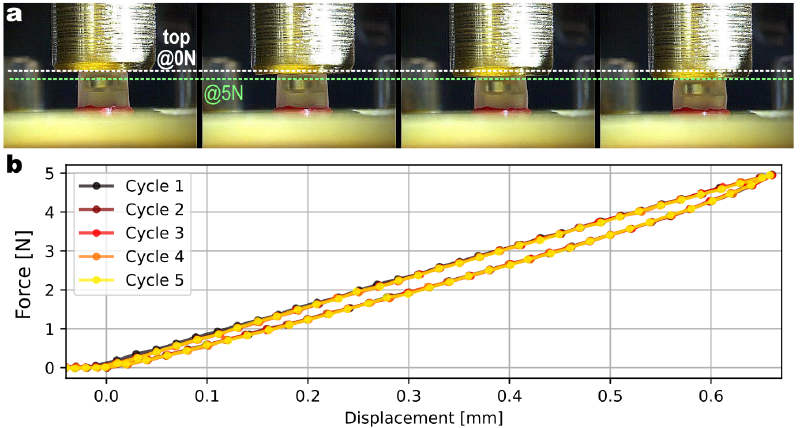
Figure 6. Mechanical response. ( a ) Time-lapse with increasing indentation and compression force, illustrating the mechanical deformation of the elastomer. ( b ) Applied compression force (measured by a reference load cell) as a function of the displacement with respect to the contact point over 5 cycles.